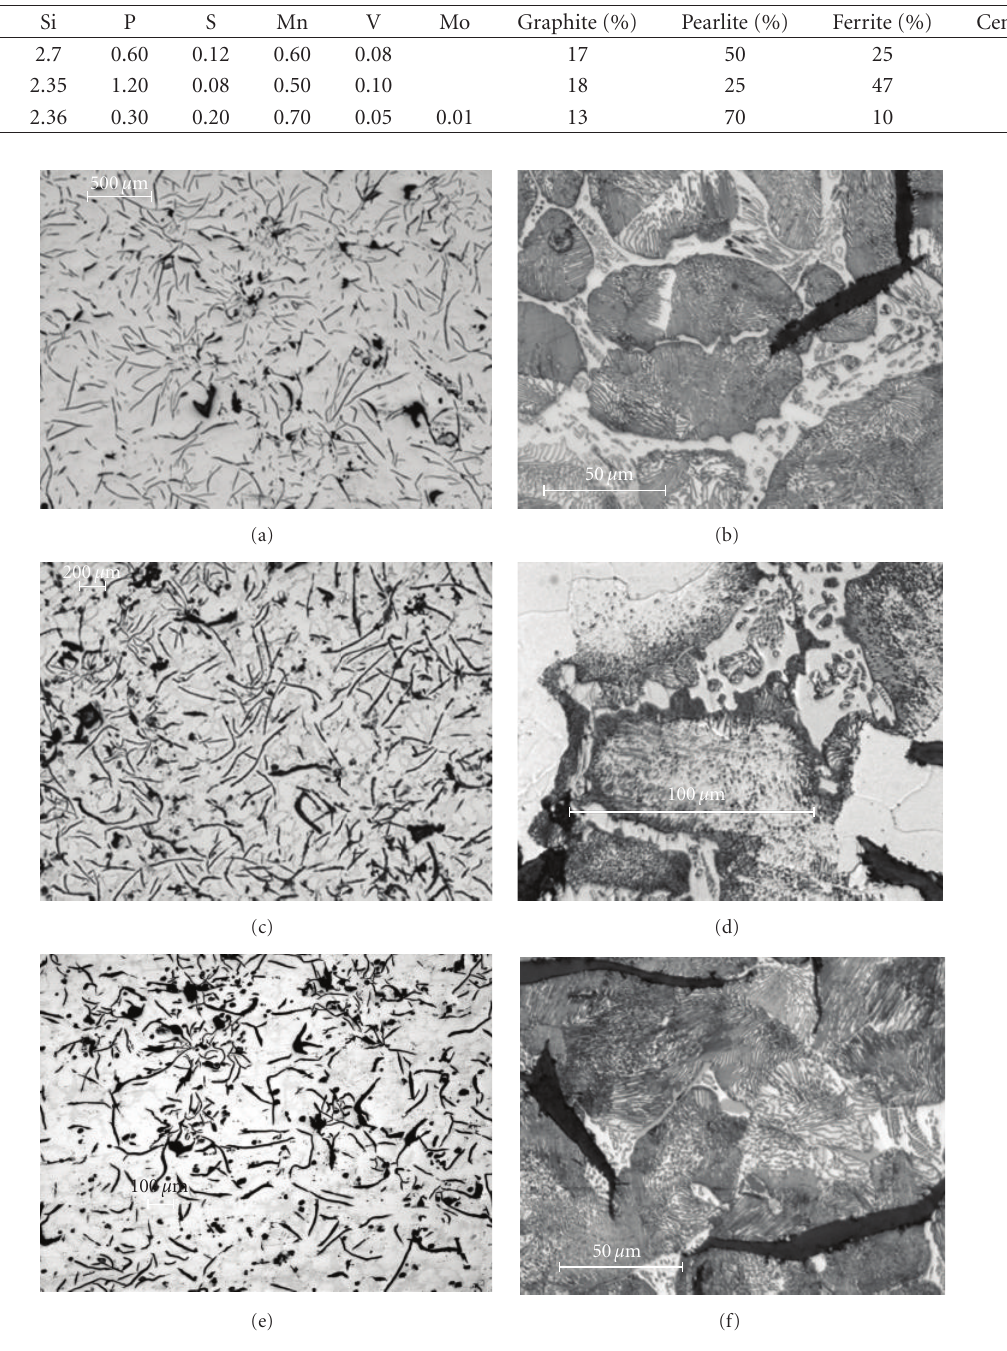
Figure 2: Morphology of microstructure for Pipes